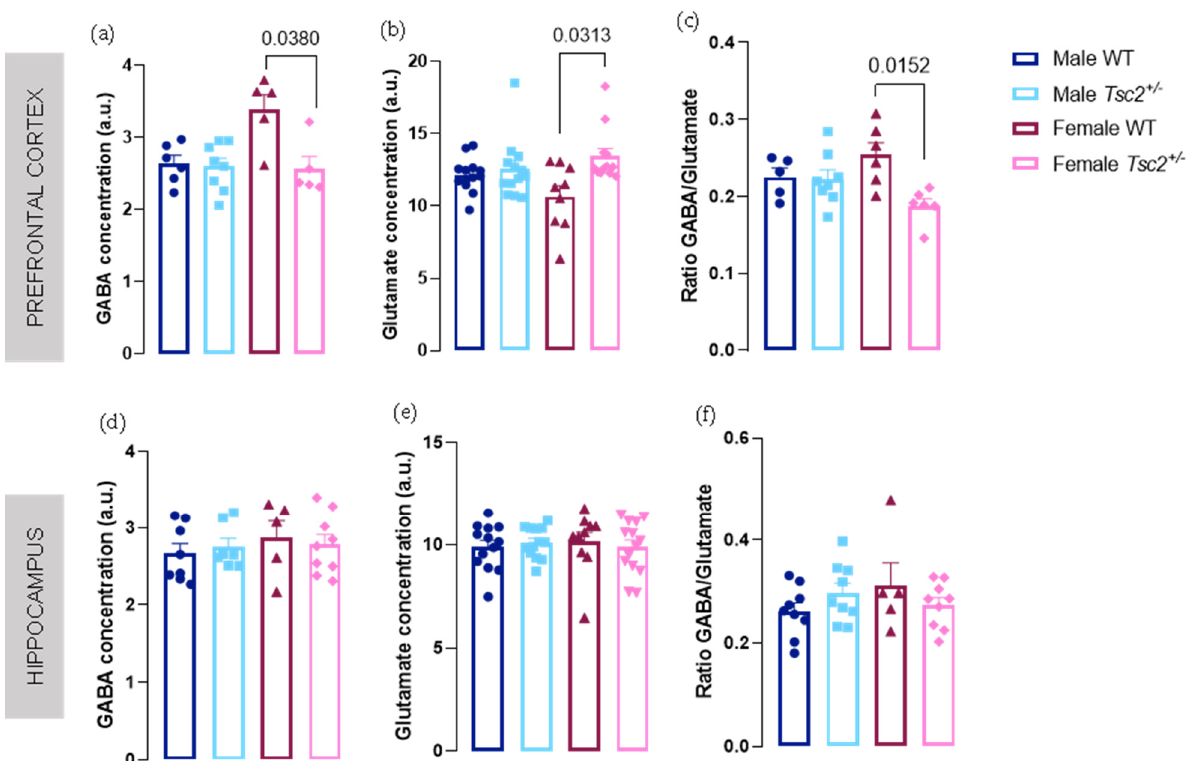
Figure 1. Excitation/inhibition balance is disturbed in a sex- and region-dependent manner. 1 H-magnetic resonance spectroscopy (MRS) analysis of concentration levels of cortical levels of ( a ) GABA and ( b ) glutamate were decreased and increased, respectively, in female Tsc2 +/ − . Accordingly, ( c ) GABA/glutamate ratio in the prefrontal cortex was altered. ( d – f ) In the hippocampus, MRS evaluation showed no changes between sex and genotypes. The results are expressed as mean ± SEM. Prefrontal cortex GABA: 24 animals (6 male WT, 8 male Tsc2 +/ − , 5 female WT, 5 female Tsc2 +/ − ); prefrontal cortex glutamate: 47 animals (13 male WT, 13 male Tsc2 +/ − , 9 female WT, 12 female Tsc2 +/ − ); prefrontal cortex GABA/glutamate ratio: 25 animals (5 male WT, 8 male Tsc2 +/ − , 6 female WT, 6 female Tsc2 +/ − ); hippocampus GABA: 29 animals (8 male WT, 7 male Tsc2 +/ − , 5 female WT, 9 female Tsc2 +/ − ); hippocampus glutamate: 50 animals (13 male WT, 13 male Tsc2 +/ − , 10 female WT, 14 female Tsc2 +/ − ); hippocampus GABA/glutamate ratio: 32 animals (9 male WT, 9 male Tsc2 +/ − , 5 female WT, 9 female Tsc2 +/ − ). Statistical analysis was performed using Kruskal–Wallis, followed by Dunn’s multiple comparison test.